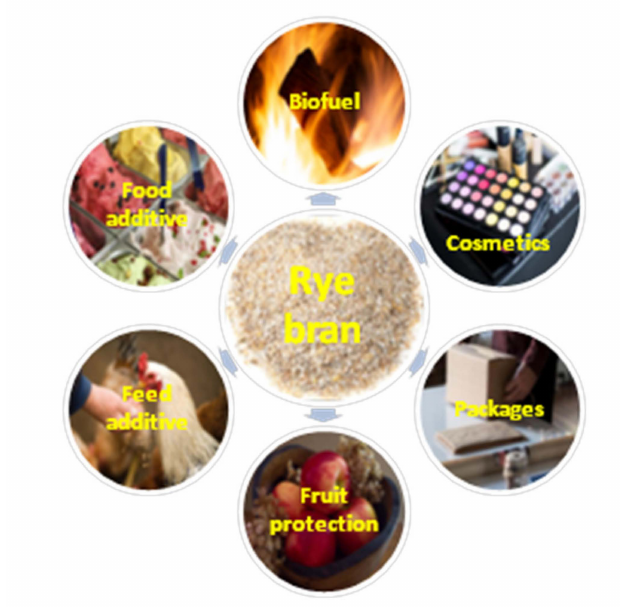
Figure 4. Recent trends in the use of rye